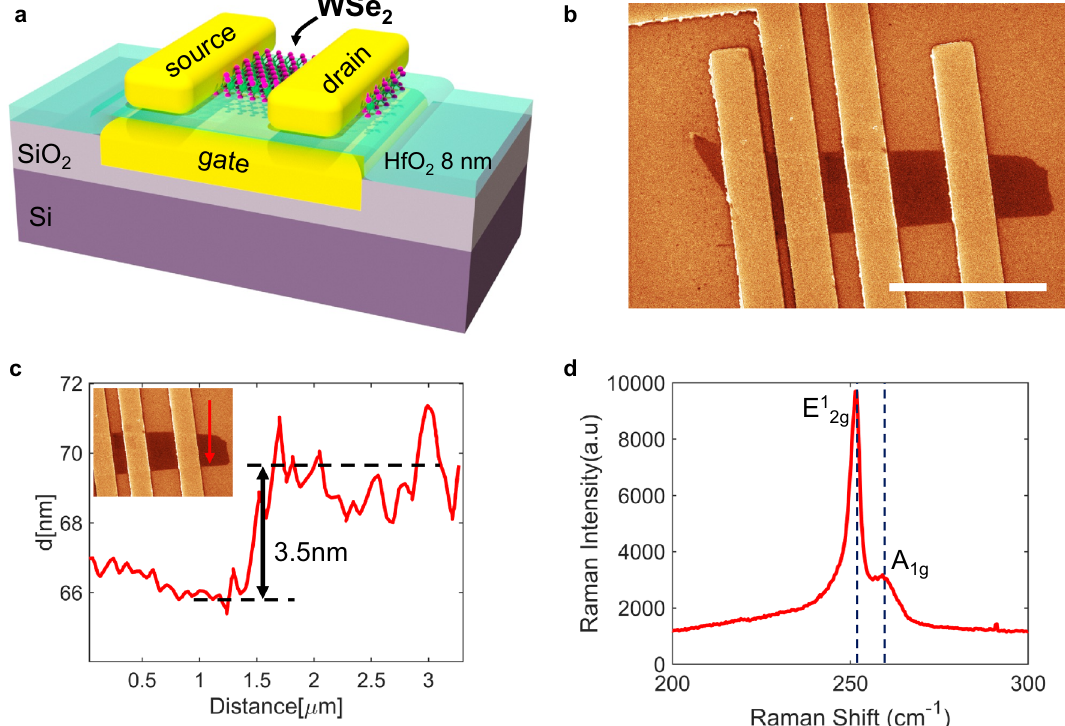
Figure 2. ( a ) Schematic of 2D WSe 2 PMOS FETs studied in this work. The FETs are configured in a transfer length method (TLM) structure and have a gate-first design with high-K metal-gate (HKMG) stack. Two different gate dielectrics were used in this work (Al 2 O 3 and HfO 2 ) with a thickness of 8 nm. See “Methods” for fabrication details. ( b ) Scanning electron microscope (SEM) image of the WSe 2 TLM structure (scale bar indicates 3 µm in length). ( c ) Atomic force microscopy (AFM) surface topography scan (non-contact mode) reveals a WSe 2 channel thickness of ~ 3.5 nm (approximately 5 layers). ( d ) Raman spectrum of the channel region showing E 1 2g and A 1g peaks consistent with ~ 5 layers of WSe 2